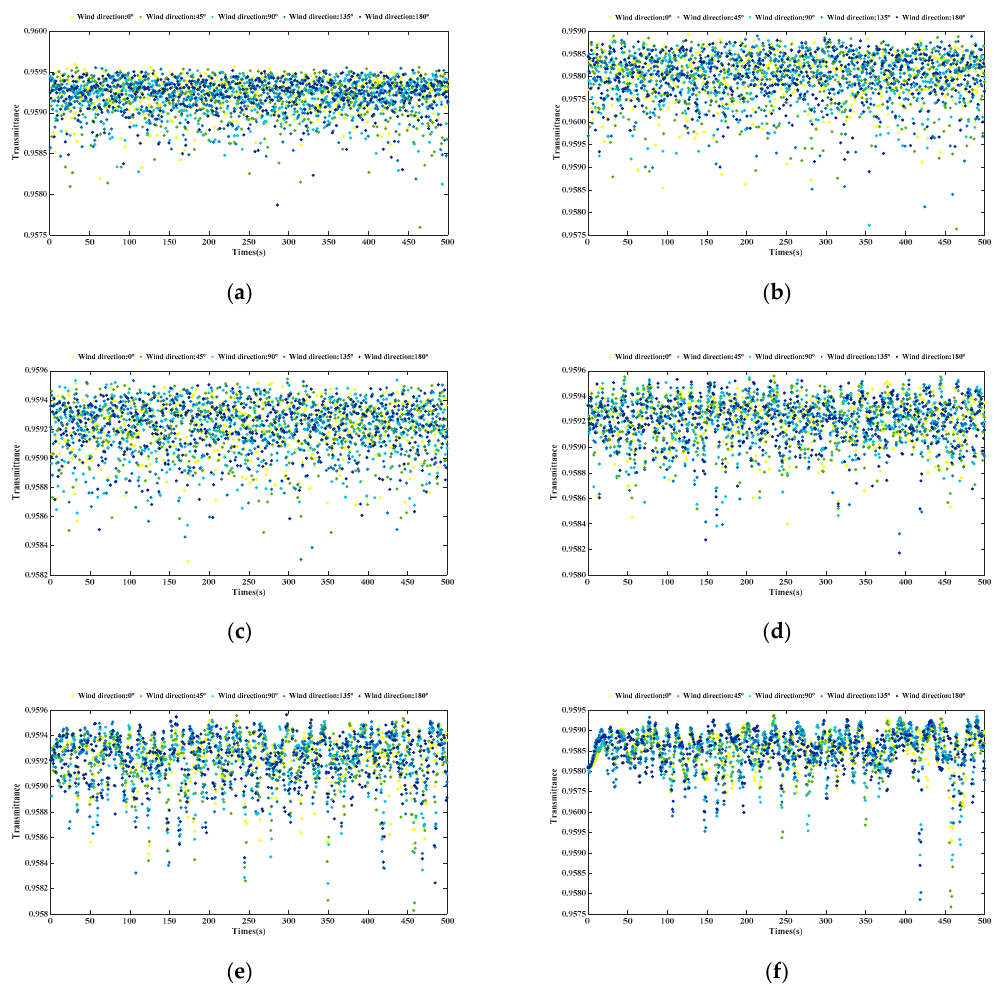
Figure 10. Scatter distribution of the transmittance of 1000 pulse spots under different wind conditions. ( a ) The wind speed is 5 m/s; ( b ) the wind speed is 7 m/s; ( c ) the wind speed is 9 m/s; ( d ) ( a ) The wind speed is 5 m / s; ( b ) the wind speed is 7 m / s; ( c ) the wind speed is 9 m / s; ( d ) the wind speed the wind speed is 13 m/s; ( e ) the wind speed is 16 m/s; ( f ) the wind speed is 20 m/s. is 13 m / s; ( e ) the wind speed is 16 m / s; ( f ) the wind speed is 20 m /